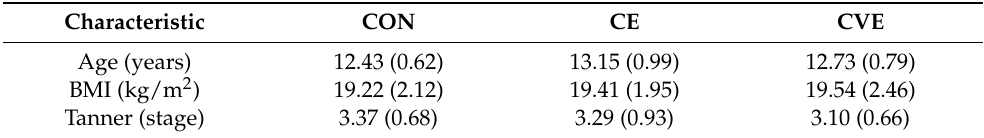
Table 1. Mean values (SD) for the basic characteristics of the two experimental groups (CE and CVE) and the control group